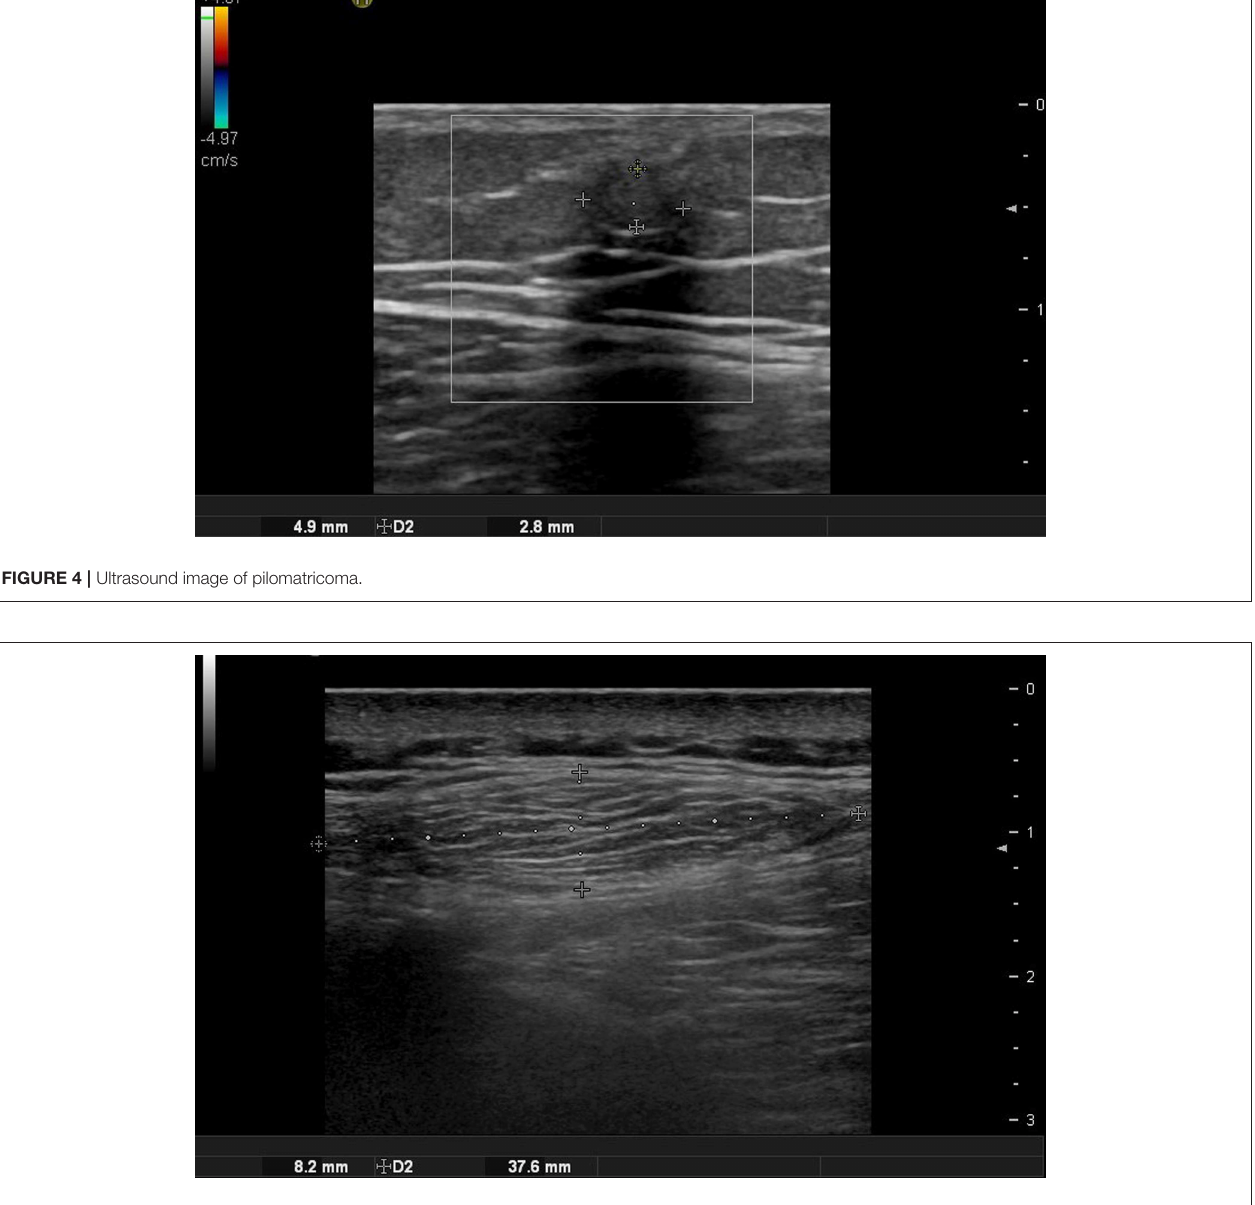
FIGURE 5 | Ultrasound image of